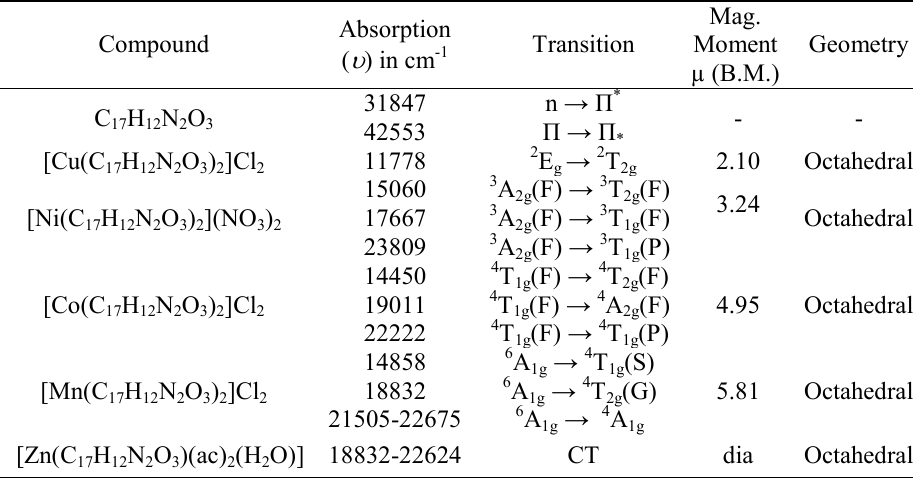
Table 4. Electronic absorption spectral data and magnetic moment values of Schiff base ligand and its metal complexes.